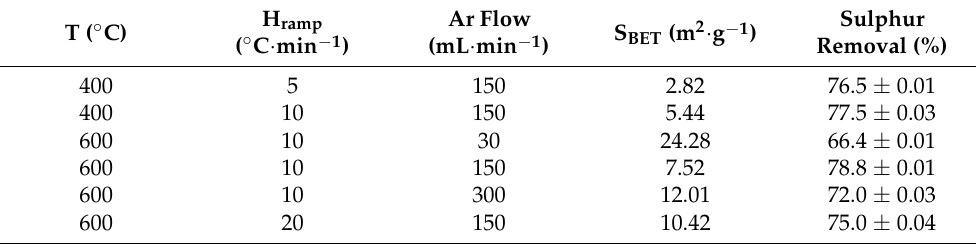
Figure 7. Effect of BET specific surface area of orange pruning biochars on sulphur removal. Table 11. Desulphurisation of waste cooking oil with orange pruning biochars obtained under different